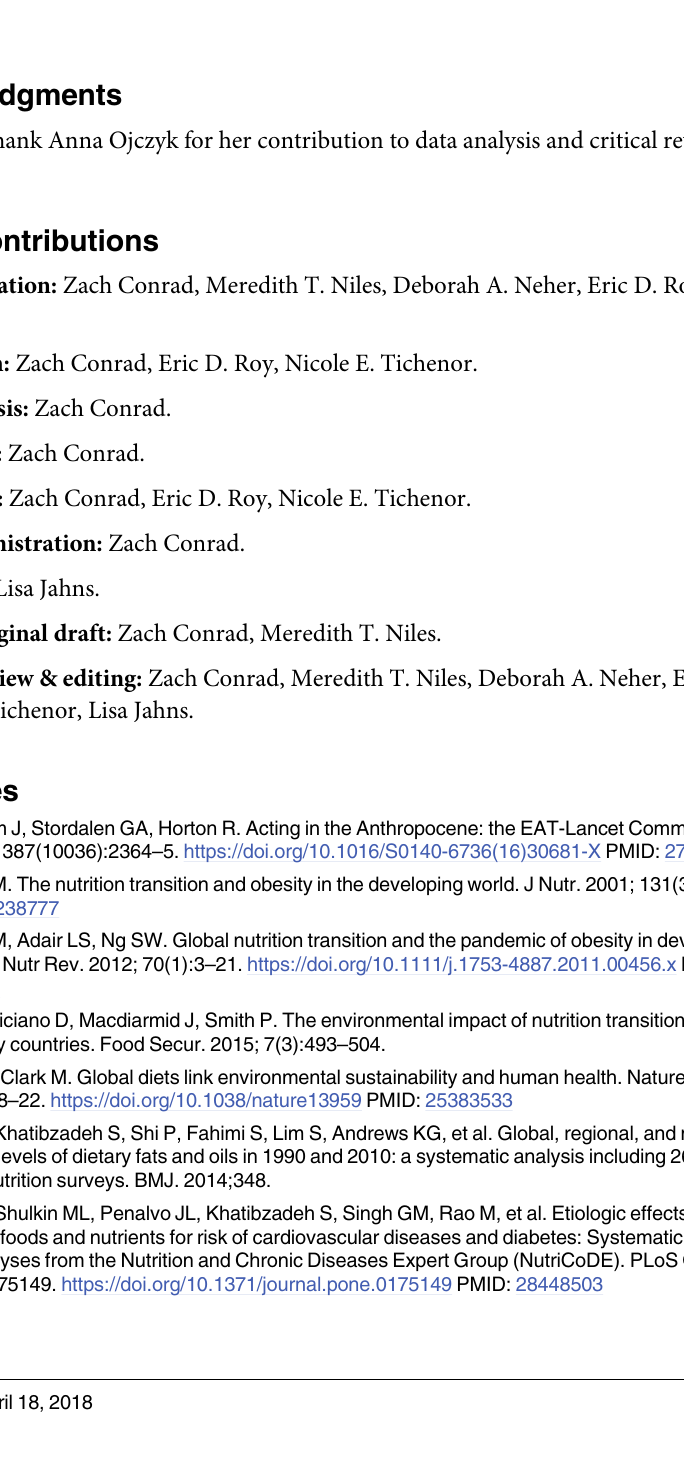
S9 Table. Annual amount of potash (K O) fertilizer used to produce wasted food, overall 2 and by Healthy Eating Index-2015 quintile (n = 35,507). S10 Table. Healthy Eating Index-2015 component scores, national health and nutrition Examination Survey, 2007–2014 (n = 35,507). S11 Table. Annual cropland used to produce wasted food, overall and by Healthy Eating Index-2015 quintile (n =